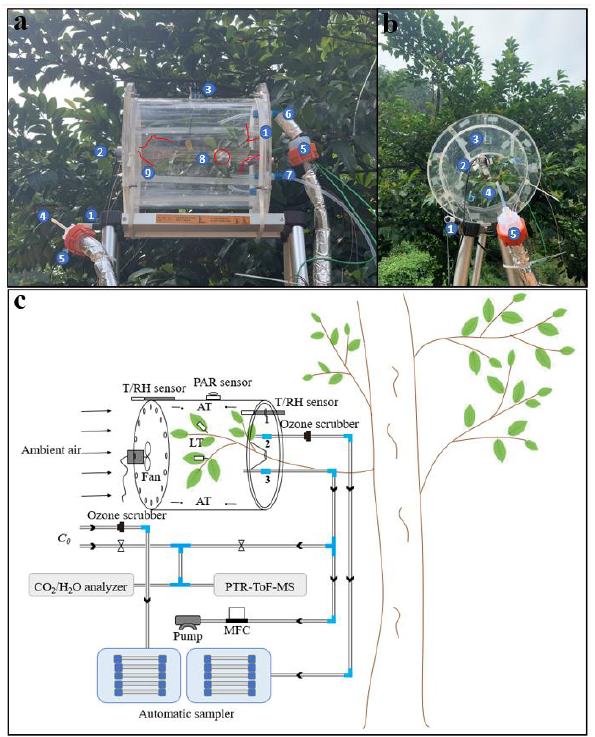
Figure 1. Photographs and schematic diagram of the semi-open dynamic chamber system for field measurements of BVOCs from plant leaves. Panels (a) and (b) are photographs of the chamber in the field: (1) T/ RH sensors, (2) Teflon fan and electric motor, (3) PAR sensor, (4) Teflon tube for sampling ambient air, (5)ozone scrubber, (6) Teflon tube for sampling chamber air, (3) Teflon tube for main airflow, (8) thermocouples (red circle) for leaf temperature, and (9) thermocouples (red lines) for chamber air temperature. (c) Schematic diagram of the chamber system. MFC refers to mass flow controller. LT and AT refer to leaf temperature and air temperature,